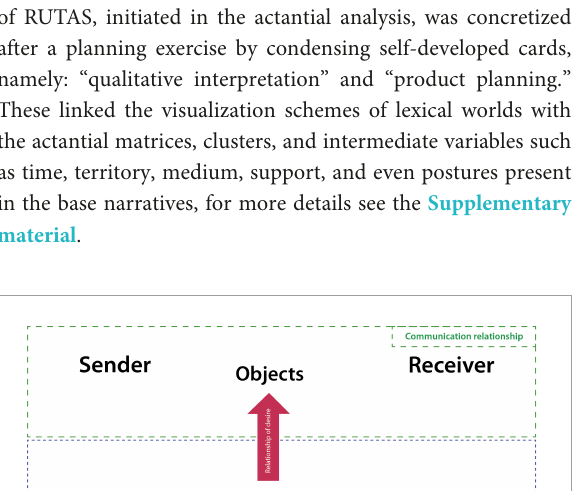
connect with the universe of meaning, which goes beyond